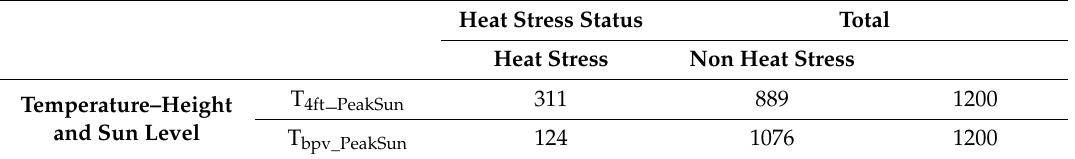
Table 5. Count of heat stress (T h ) cases across temperature–height levels during peak sun.